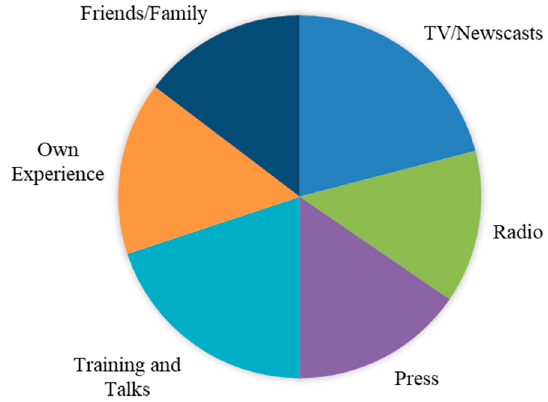
Figure 1. Knowledge of situations of violence as a function of sources of information. TV = TV news/Television.